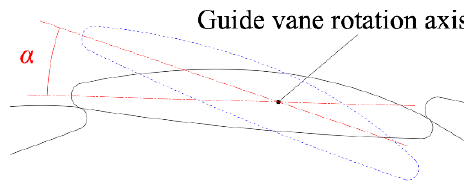
Figure 1. Definition of GV opening angle α.